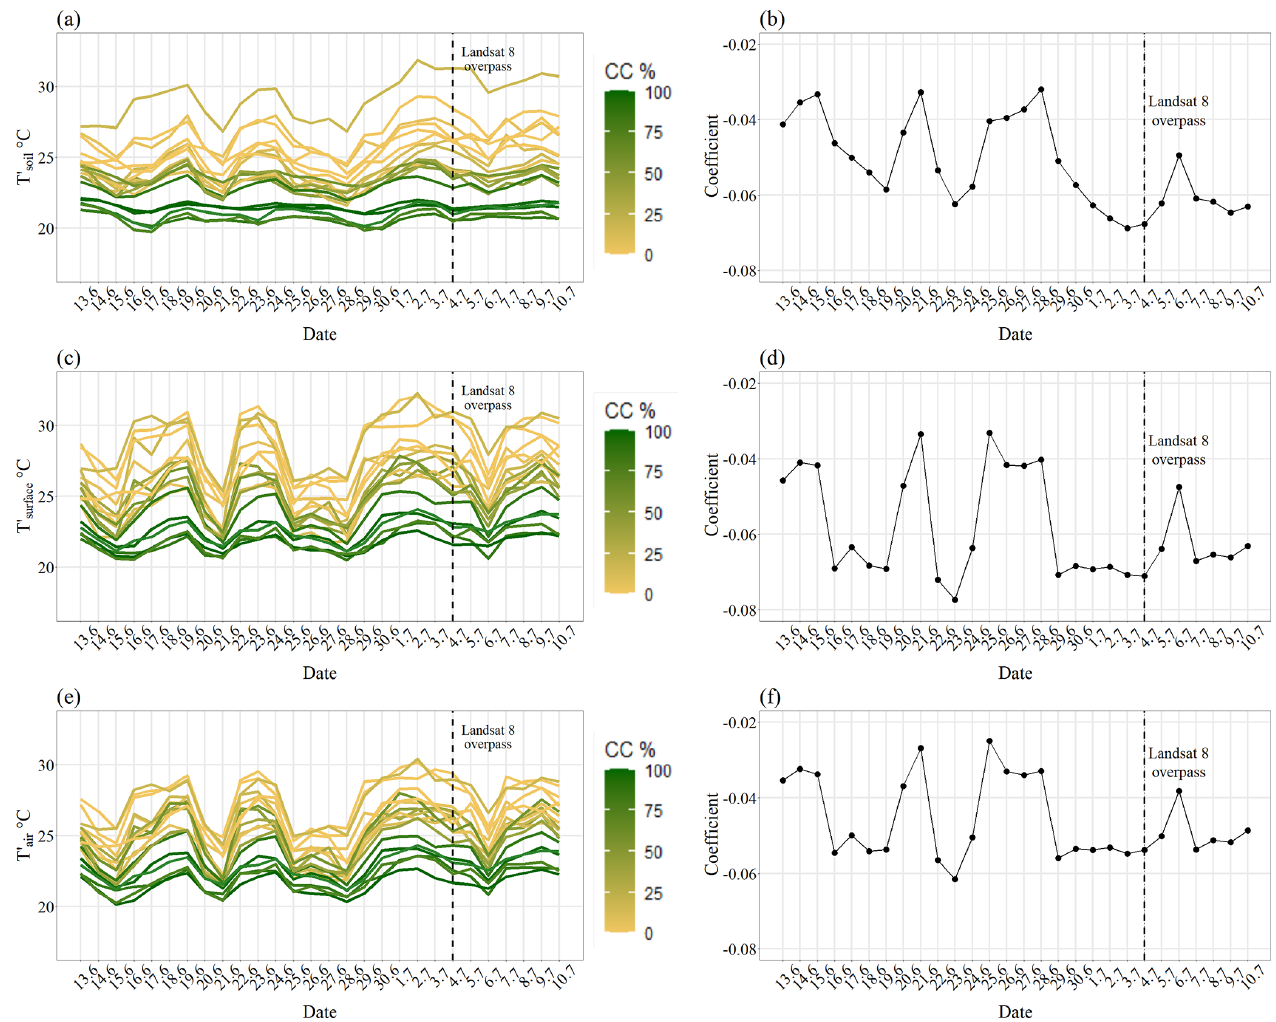
Figure 4. Daily variation in topographically corrected daytime (6.30–18.30) mean temperatures ( T (cid:48) ) between 13 June and 10 July 2019 (a, c, e) and cooling effect of canopy cover (described by regression coefficient) (b, d, f) . Line color indicates canopy cover (CC) percentage. Dashed line represents the overpass date of Landsat 8 (4 July 2019). (a–b) Soil temperature. (c–d) Surface temperature. (e–f) Air